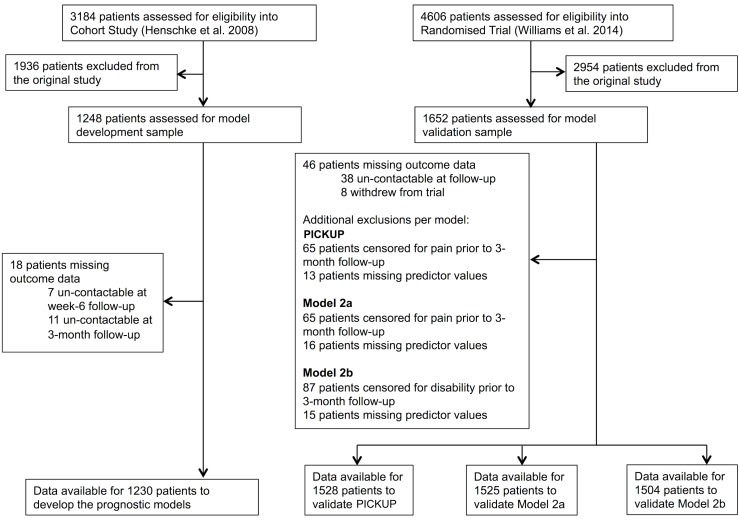
Patient flow chart.The current study used non-identifiable data originally published in Henschke et al. [33] (development sample) and Williams et al. [23] (external validation sample).